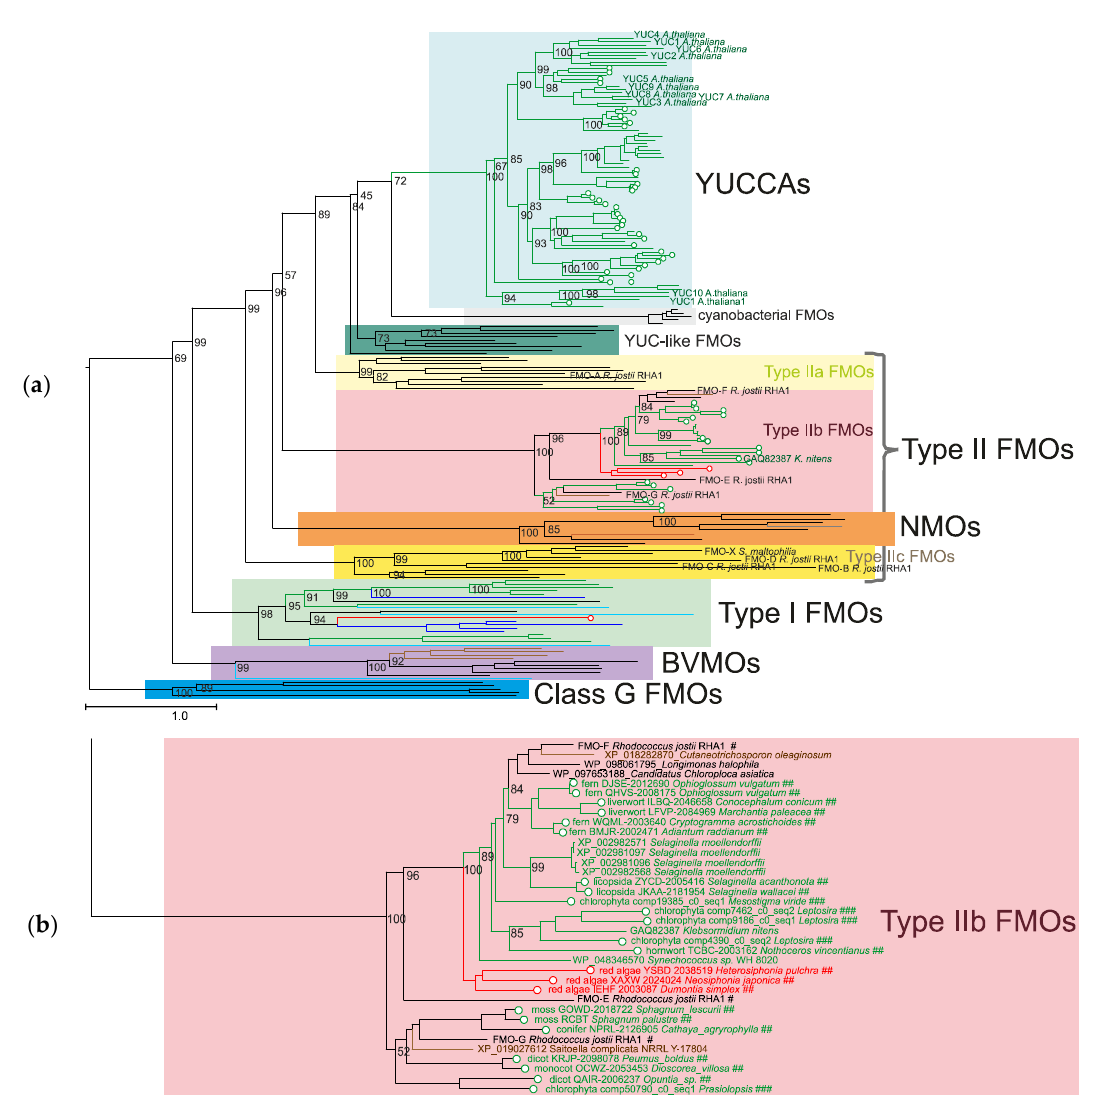
Figure 4. The phylogenetic tree (IQ-TREE method) of class B flavoprotein monooxygenases, including sequences from the transcriptomic assemblies. ( a ) The phylogenetic tree of class_B_FMO_proteins_and_transcriptomic, with class G flavoprotein monooxygenases as an outgroup. The sequences from the 1KP project [49] and the Green Algal Tree of Life Project [50] transcriptomic assemblies are marked with a circle. The sequences of green algae and land plants are colored green; of red algae, red; of fungi, brown; of protists, cyan; of animals, blue; of bacteria, black; of archaebacteria, gray. ( b ) A fragment of the phylogenetic tree of FMOs (extended by transcriptome sequences) for the type IIb FMO clade. The designations are the same as in ( a ). Additionally, three protein sequences marked with # are extracted from Riebel et al. [40], with ##, from the 1KP project [49], and with ###, from the Green Algal Tree of Life Project [50]. The numbers near the branches represent bootstrap support values.